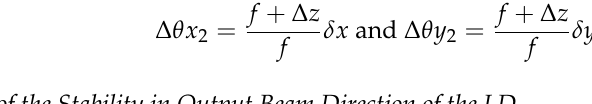
Figure 5. Effect of the position offset on the measurement accuracy ( a ) without the angular error, ( b ) with the angular error and ( c ) with the straightness error.